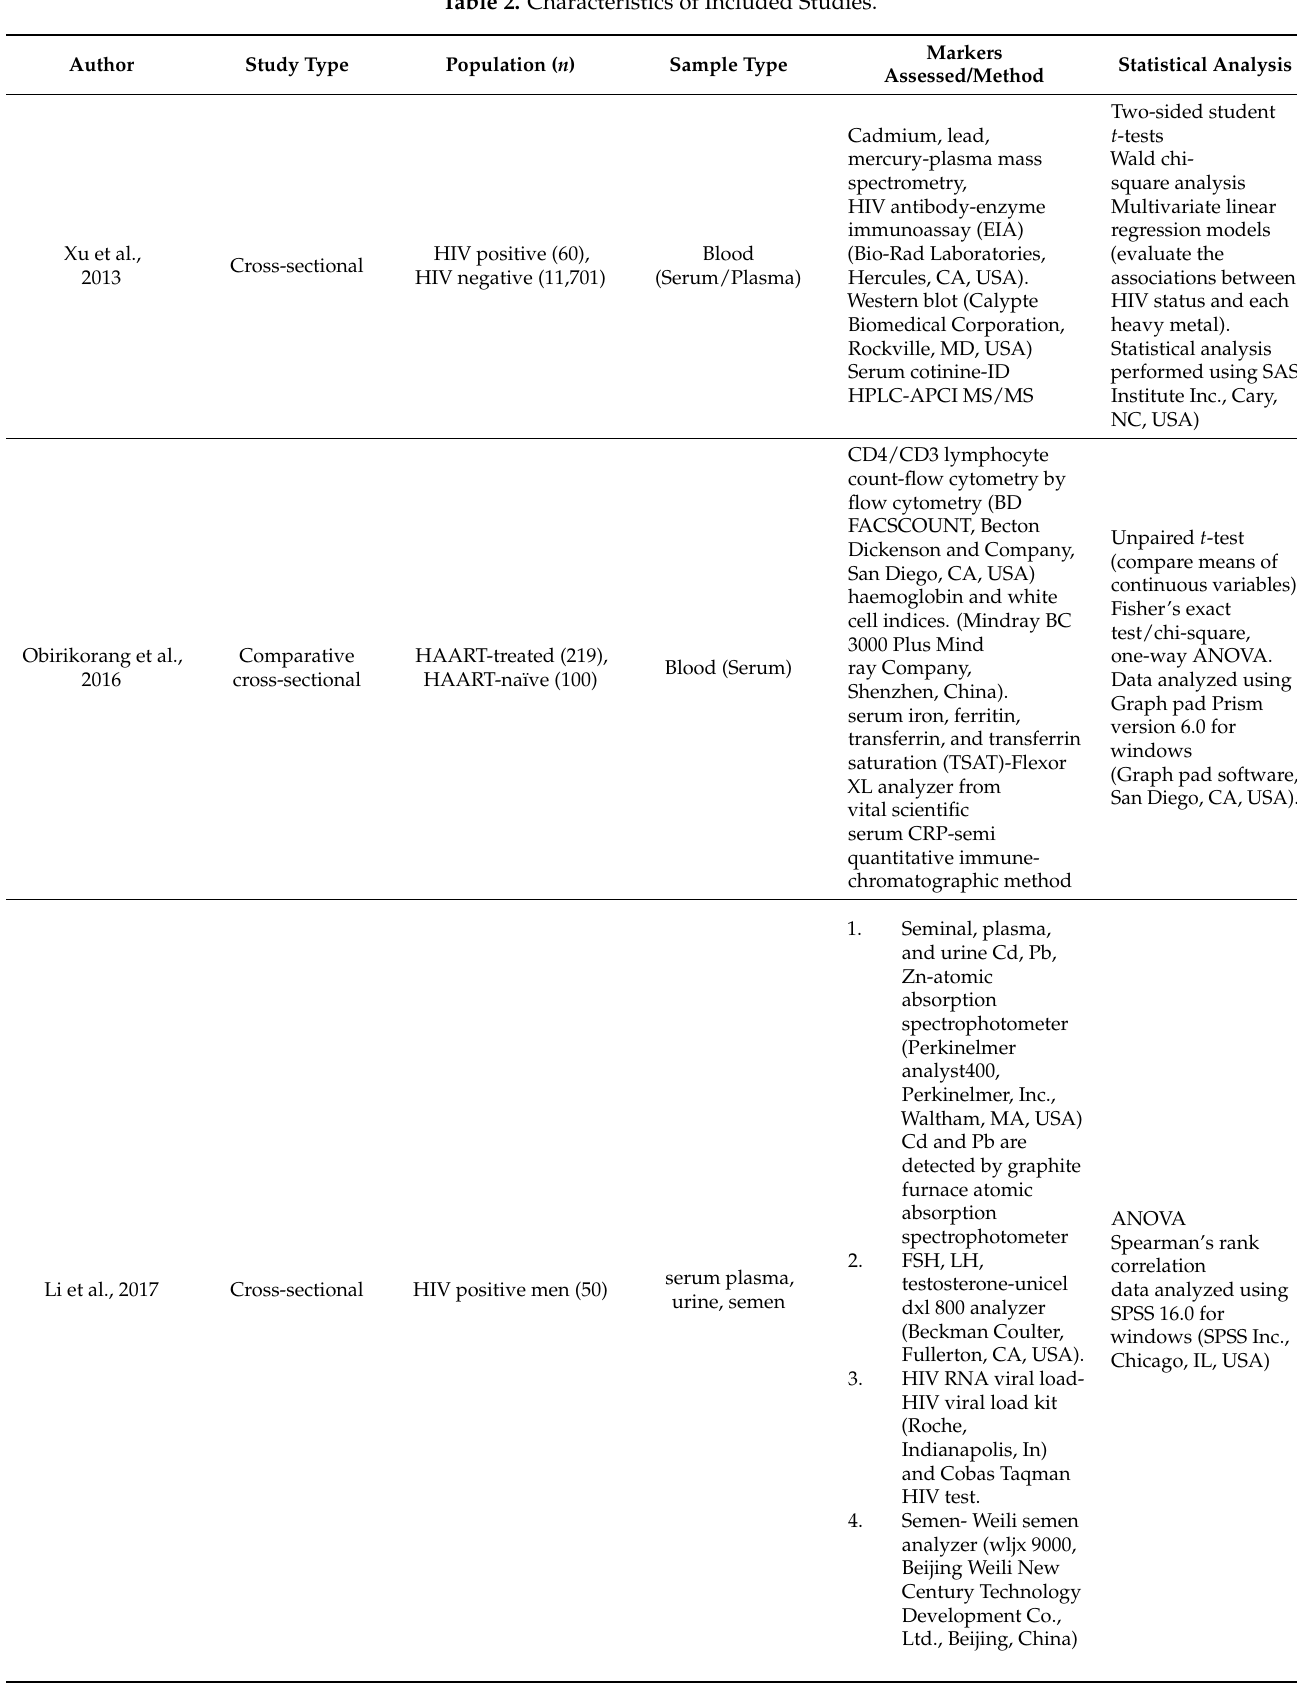
Table 2. Characteristics of Included